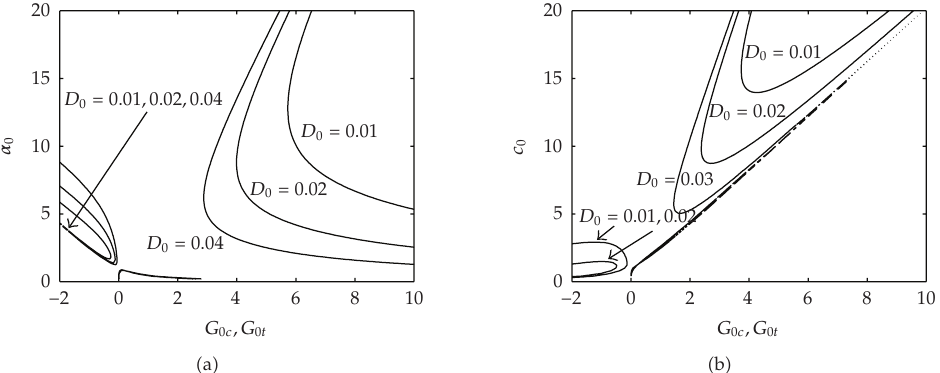
Figure 4: Linear neutral (cid:3) a (cid:4) wave number and (cid:3) b (cid:4) wave speed against the buoyancy parameters (cid:3) G 0 t ,G 0 c (cid:4) when D 0 (cid:8) 0 . 01 , 0 . 02 , 0 . 03 and 0 .